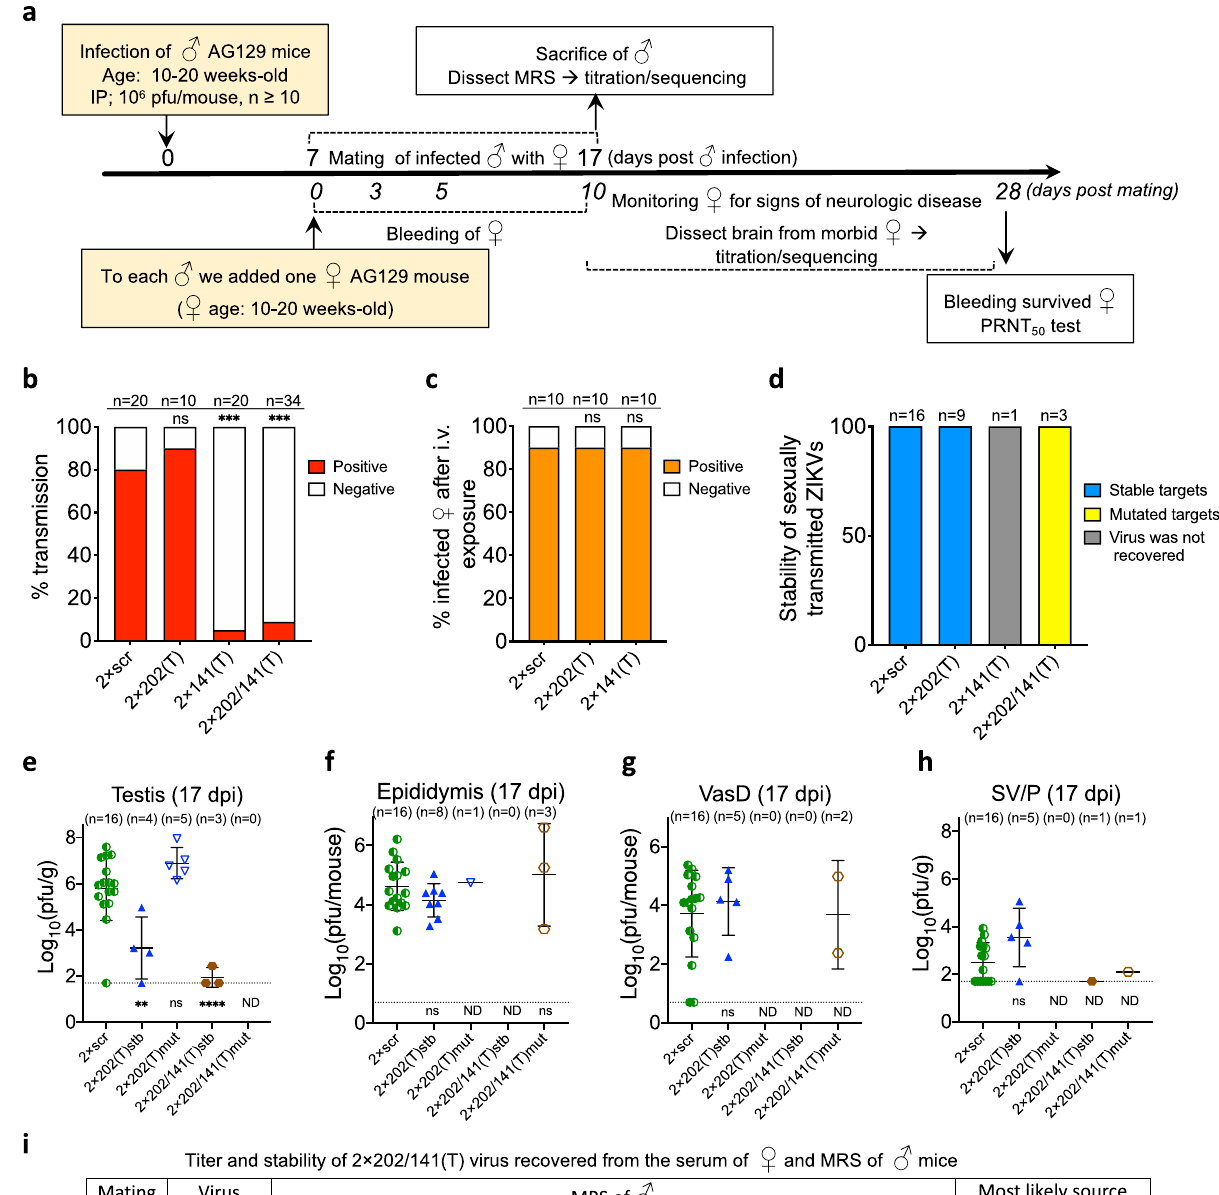
was signi fi cantly lower than that of 2 × scr virus (see 2 × 202(T) stb in Fig. 3e, p < 0.001, one-way ANOVA). In the testes obtained from the remaining fi ve mice, the 2 × 202(T) virus acquired escape mutations (see 2 × 202(T)mut in Fig. 3e), which were associated with ~5000-fold increase in the virus titer in the testis as compared to the titer of 2 × 202(T)stb. However, these escape mutants were not detected in the female serum (Fig. 3d), which suggests that testicular infection of ZIKV does not contribute to the pool of the viruses transmitted from male to female mice. At 17 dpi, the titers of 2 × 202(T)stb and 2 × scr viruses were very similar in the epididymis, vas deferens, and SV/P (Fig. 3f – h),